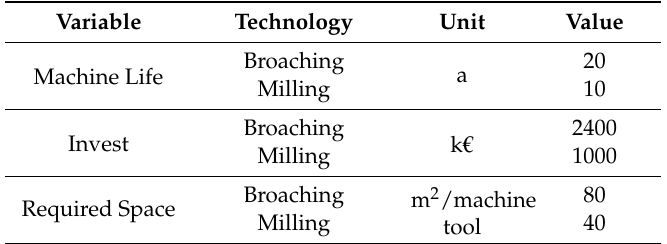
Table 3. Technology dependent assumptions for the economical assessment.